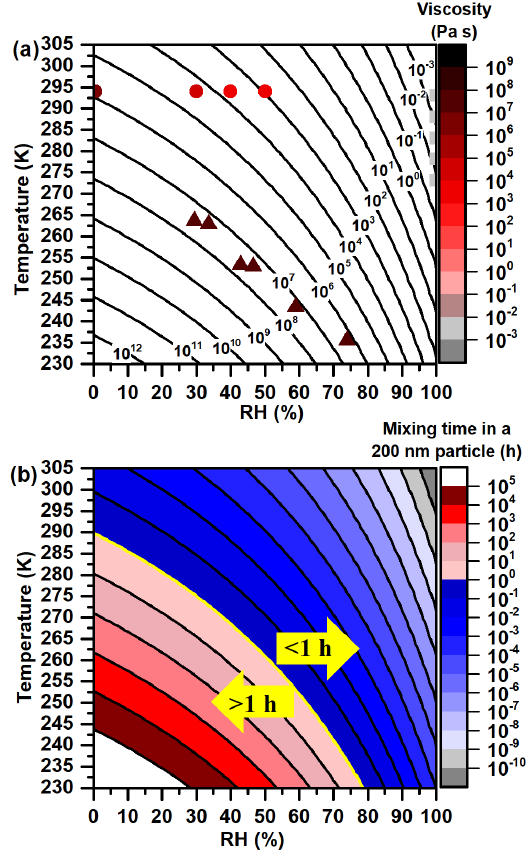
Figure 2. Plot of RH vs. temperature with contour lines rep- resenting (a) our viscosity parameterization for α -pinene SOA particles and (b) mixing times calculated for organic molecules within 200nm diameter α -pinene SOA particles. The symbols in (a) represent the laboratory data used to develop the parame- terization: squares represent the water viscosities from Crittenden et al. (2012), triangles represent the viscosity data of α -pinene SOA from Järvinen et al. (2016), and the circles represent the viscos- ity data from Grayson et al. (2016). The viscosity parameterization is based on α -pinene SOA generated using mass concentrations of ∼ 1000µgm − 3